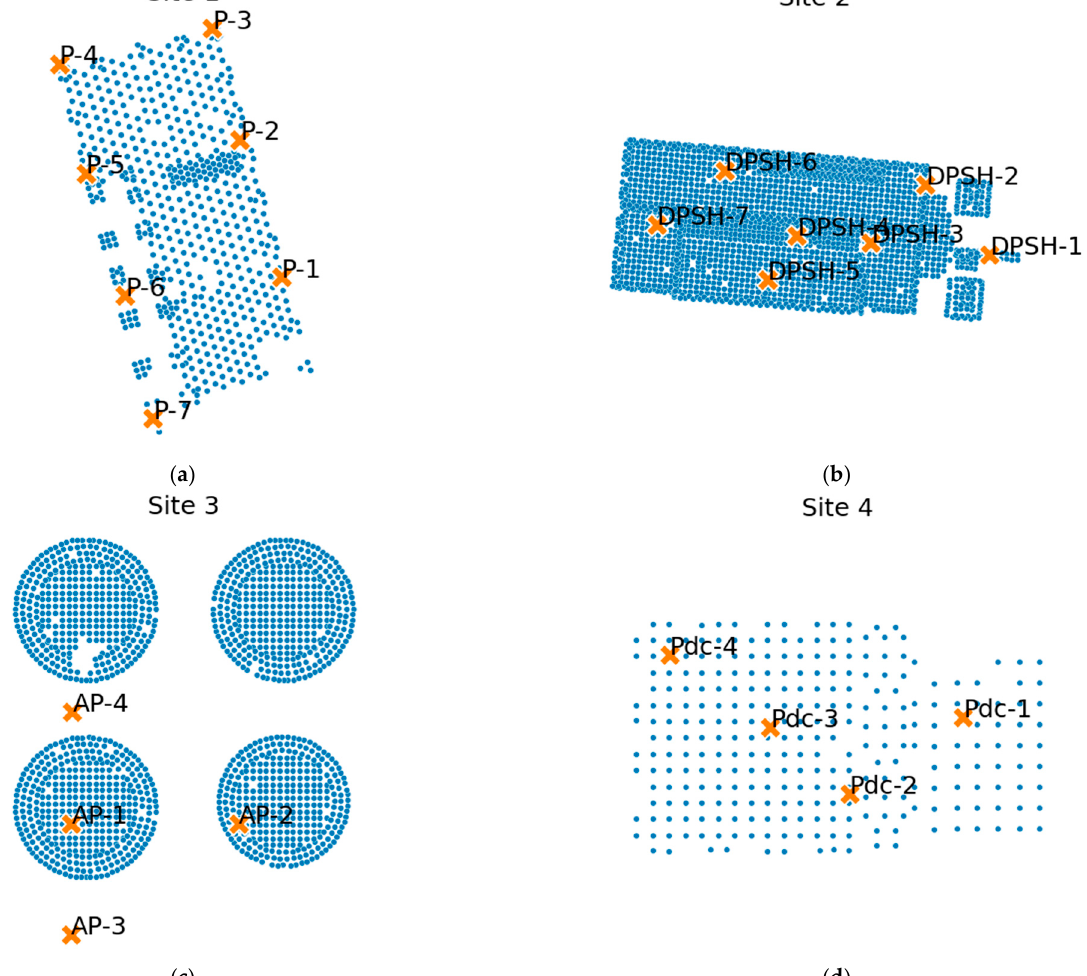
Figure 1. Distribution of columns (circles) and penetrometers (crosses) available in the analyzed sites. ( a ) Site 1. ( b ) Site 2. ( c ) Site 3. ( d ) Site 4.